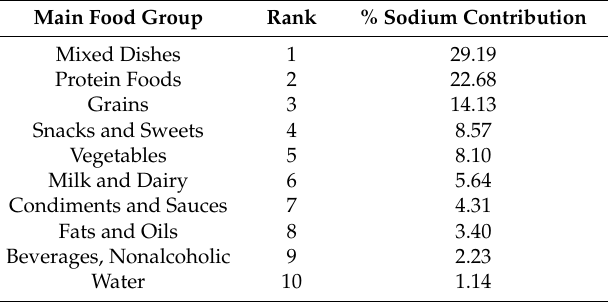
Table 16. Food sources of sodium contribution in the total U.S. diet, adults ≥ 51 years old ( n = 4522; gender combined; daily intake data; NHANES 2011–2014; main food groups contributing <1.0% not reported; data are Day 1